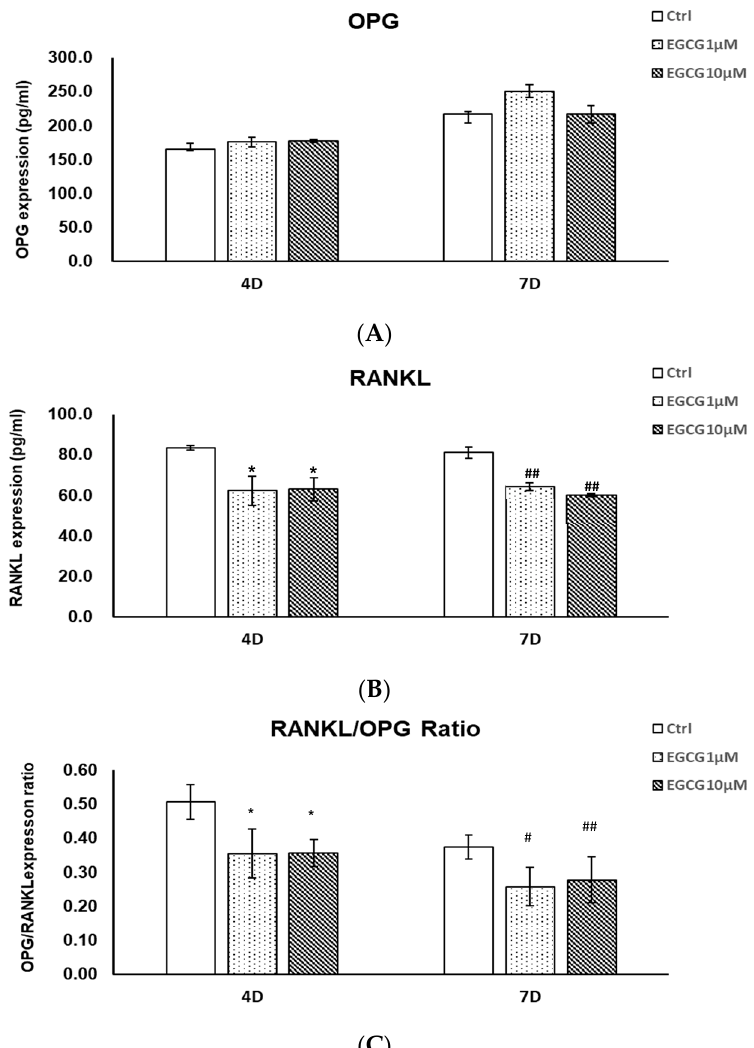
Figure 3. Secretory OPG and RANKL expression by ELISA. There was no significant change in OPG secretion after EGCG treatment at either 1 or 10 µmol/L ( A ). Like mRNA expression, secreted RANKL decreased after EGCG treatment for 4 and 7 days at concentrations of both 1 and 10 µmol/L ( B ). The ratio of RANKL/OPG decreased after EGCG treatment for four ( p < 0.05) and 7 days ( p < 0.01) at concentrations of both 1 and 10 µmol/L ( C ). **: p < 0.01 compared with day 4 control. ##: p < 0.01 compared with day 7 control.